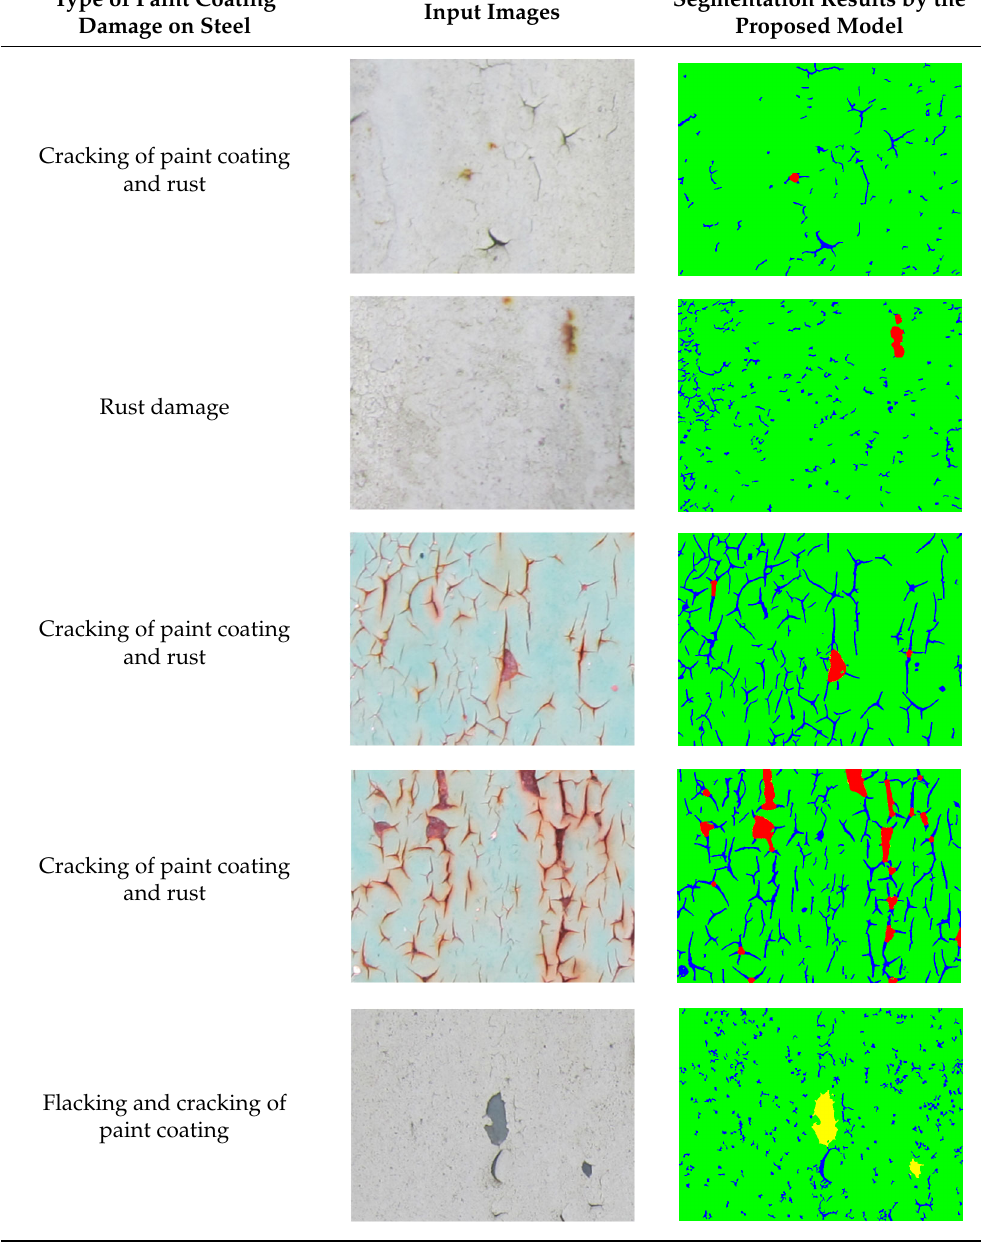
Table 4. Examples of valley detection for different threshold values 𝑇 . Table 5 illustrates the segmentation results of the input image at different stages of the algorithm functionality. As mentioned earlier, preliminary coarse segmentation of the input image is performed in the first stage. In our case, the input image is segmented by the valley detection method (second image) and multiclass SVM (third image). These two segmentation results then serve as an initialization for the level ‐ set method with a de ‐ veloped penalty term (9) for a more accurate final segmentation (fourth image). The ground truth is given as the fifth image for comparison.